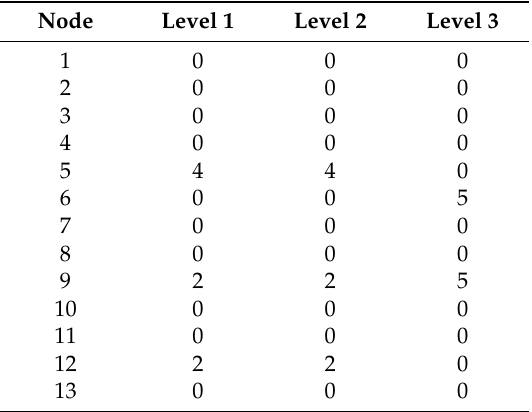
Table 9. Comparison of the charging station construction programs